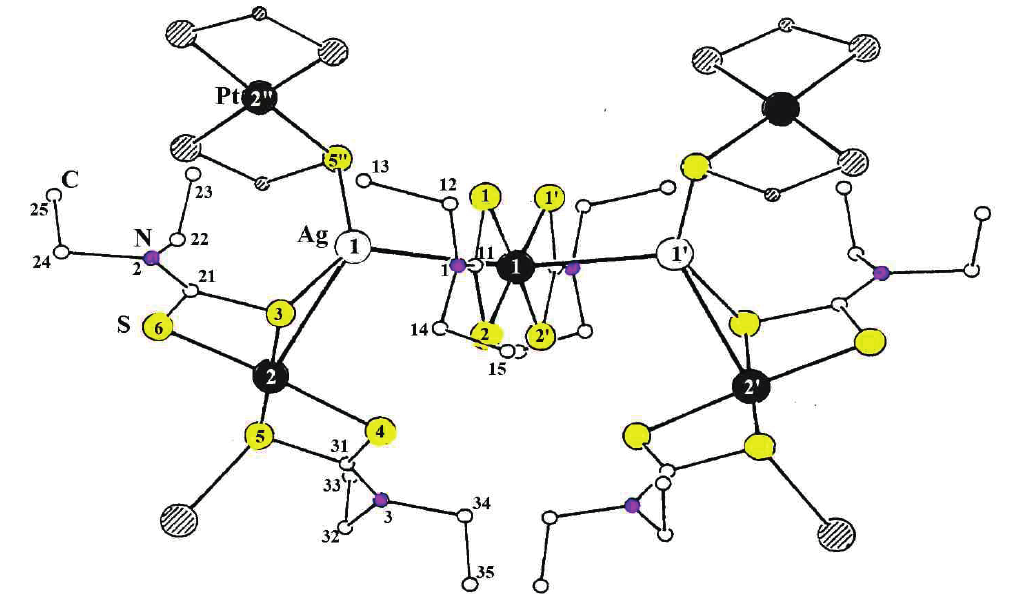
(S CNEt ) Ag ] 2+ [45]. 3 2 2 6 2